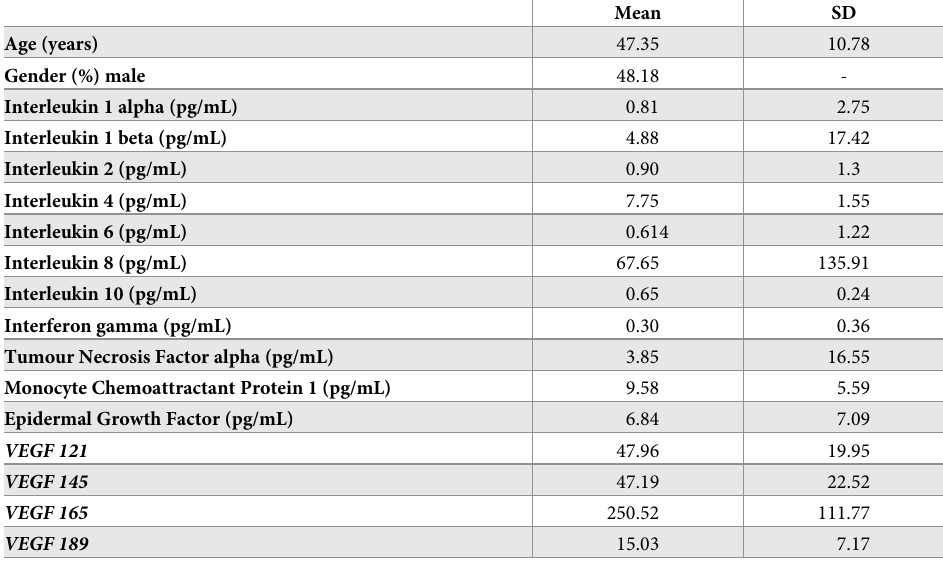
Table 4. Characteristics of the subsample of the population used for assessment of associations between inflam- matory molecules levels from PBMCs extracts and VEGF mRNA isoforms (n = 110).